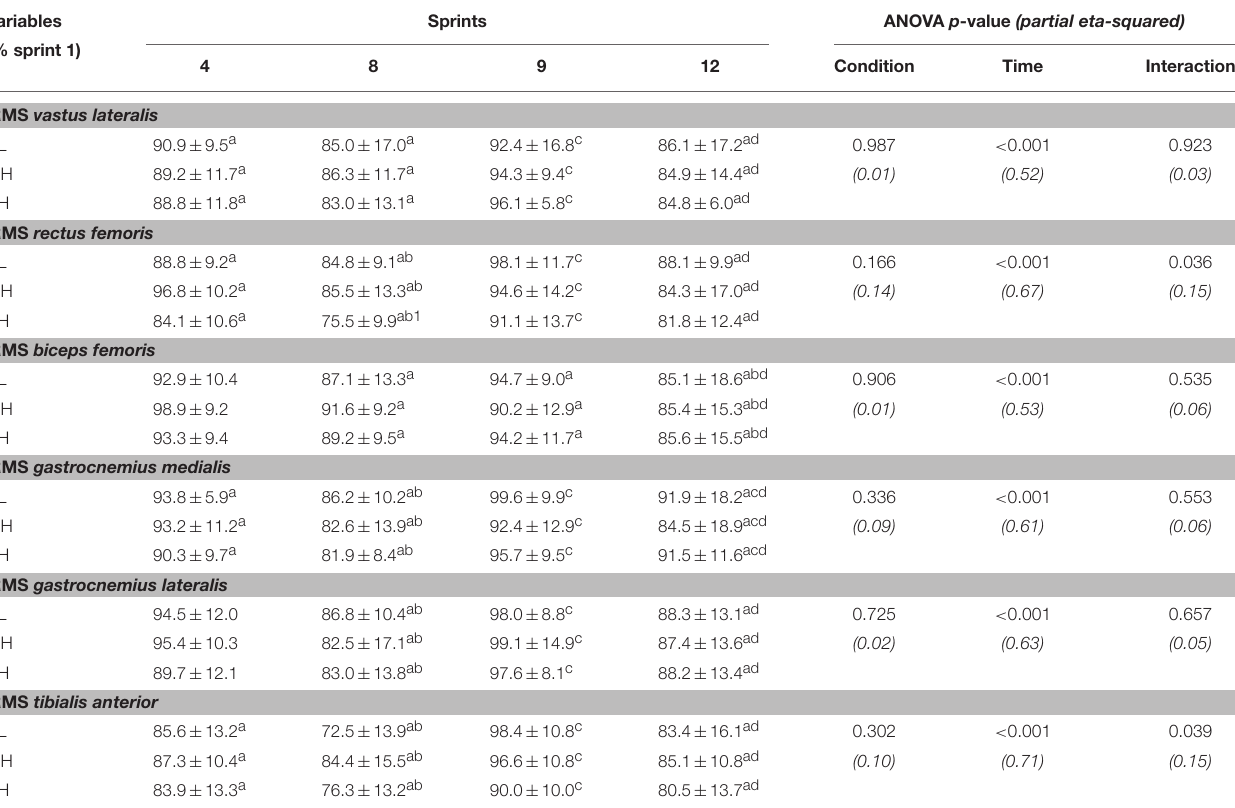
TABLE 2 | Surface EMG root mean square (RMS) activity. Variables